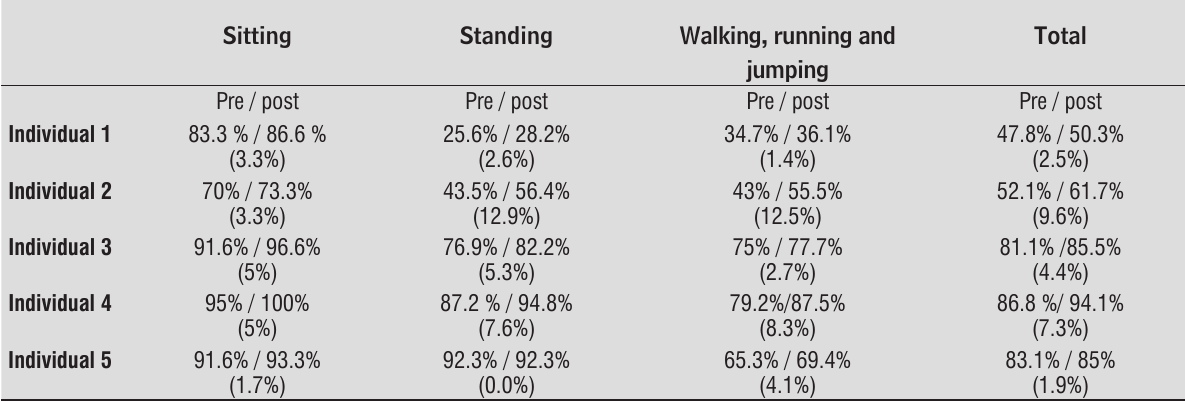
Table 2 - Results obtained by calculating the GMFM scale score before and after application of the exercises with the Wii ® video